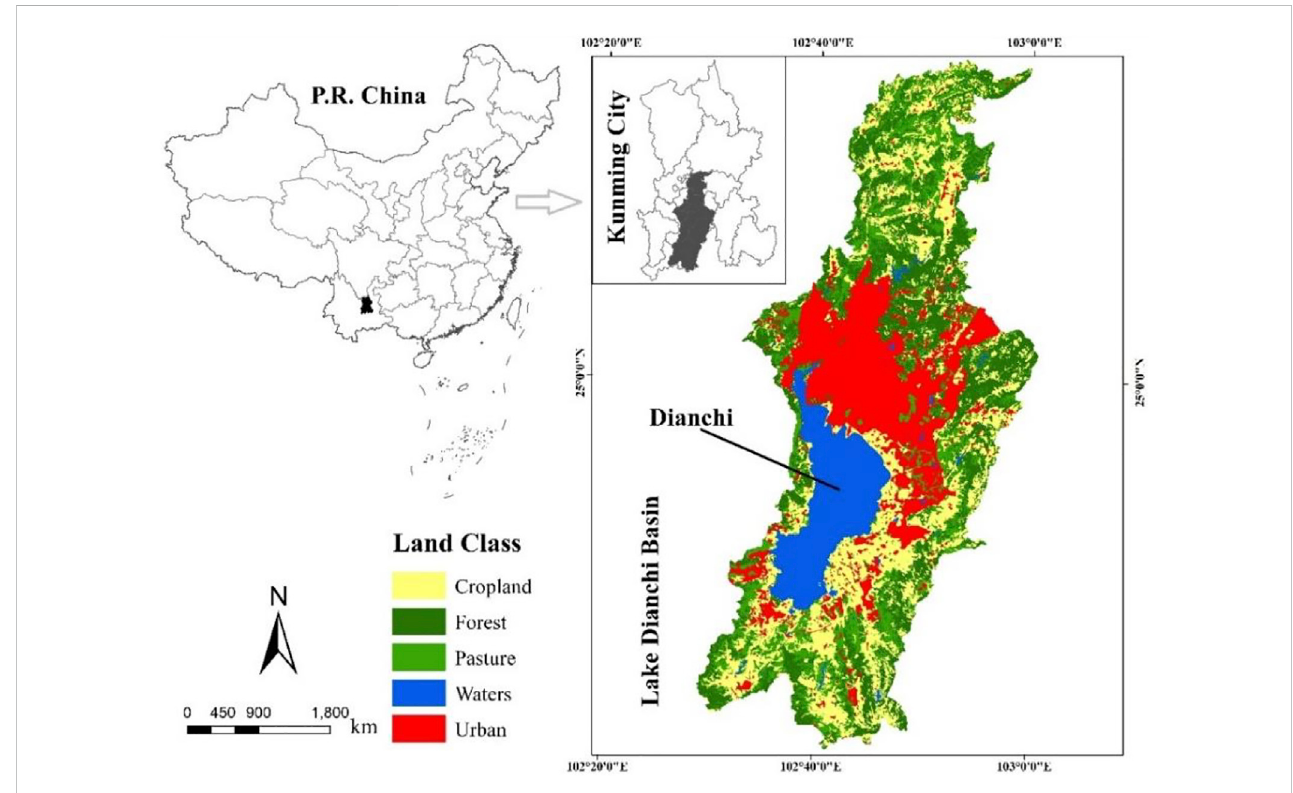
FIGURE 1 Map showing the geographical location and land use of Dianchi Lake basin in 2018.